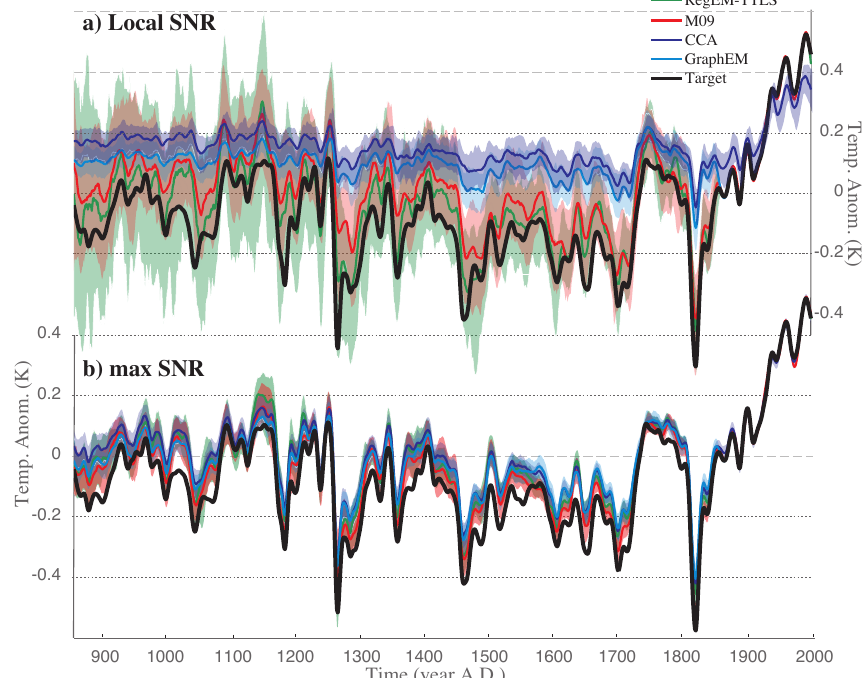
Fig. 5. Area-weighted global mean time series comparison of the four CFR methods, with the staircase network. (a) local SNR, (b) max SNR. Only the low-frequency (20yr lowpass) signal is plotted. Black line: target temperature from the CSM1.4 model output; colored lines: reconstructed temperature from median of the reconstruction ensembles; shaded areas: 2.5–97.5 percentiles derived from the reconstruction